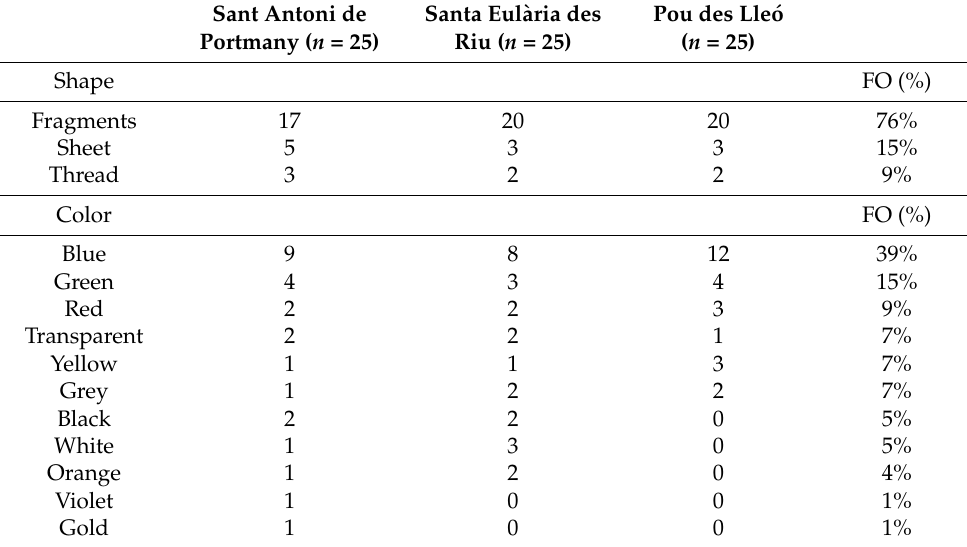
Table 2. Total number ( n = 75) and frequency of occurrence (FO) of differently shaped and colored mesoplastic items recovered of the three stations: Sant Antoni de Portmany, Santa Eul à ria, and Pou des Lle ó . Sant Antoni